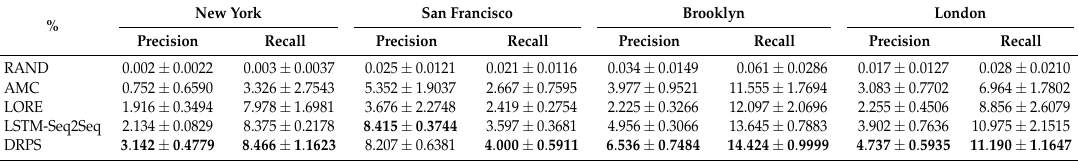
Table 5. Performance comparison on four cities in terms of precision and recall under the setting where the input and output lengths are, respectively, 25 and 10. The numbers in bold face indicate the ones with the best